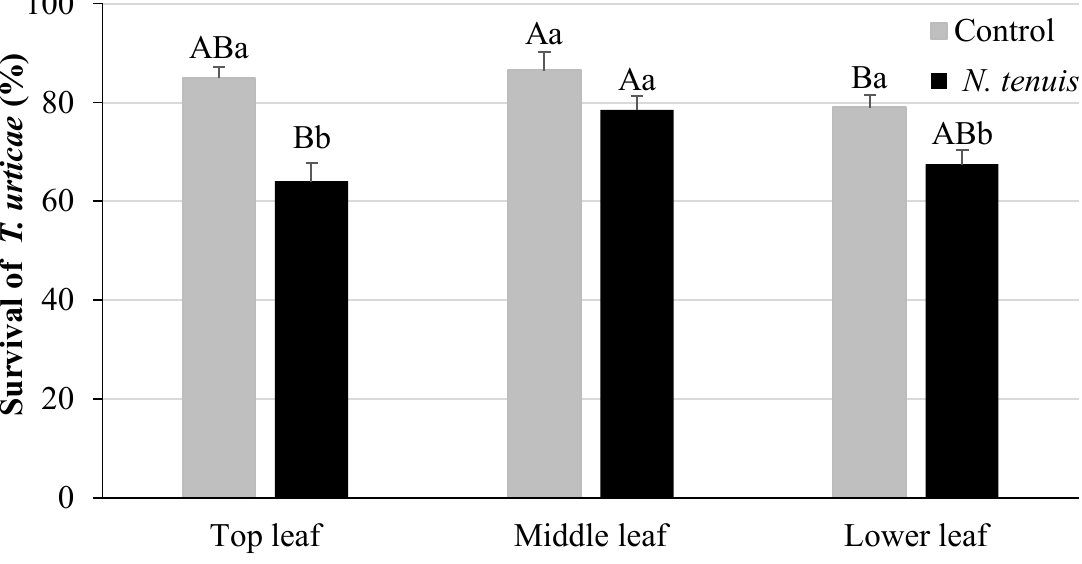
Figure 3. Survival rate (% of alive individuals ± SE) of T. urticae 48 h after their release on tomato plants punctured with N. tenuis , in comparison to unpunctured plants on top, middle, and lower leaves of tomato plants. Columns with the same capital letter are not significantly different among leaves within each treatment, and columns followed by the same small letter are not significantly different between the treatments in each leaf category (ANOVA, Tukey HSD, p < 0.05, n = 10).